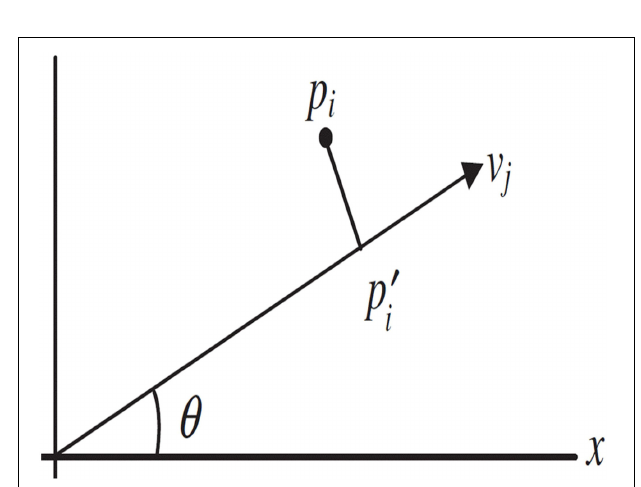
FIGURE 1 | CoPlot: Adding the variable vectors. The point p i corresponds to the coordinates for observation i = 1, ... , n. The vector v j is for the variable j = 1, ... m. The x-axis is rotated through an angle θ to give a point p (cid:2) i , which is the projection of p i onto the vector v j . The correlation between the n new projected scores and the original n values for variable j are computed, and the choice for θ is the one that maximizes this